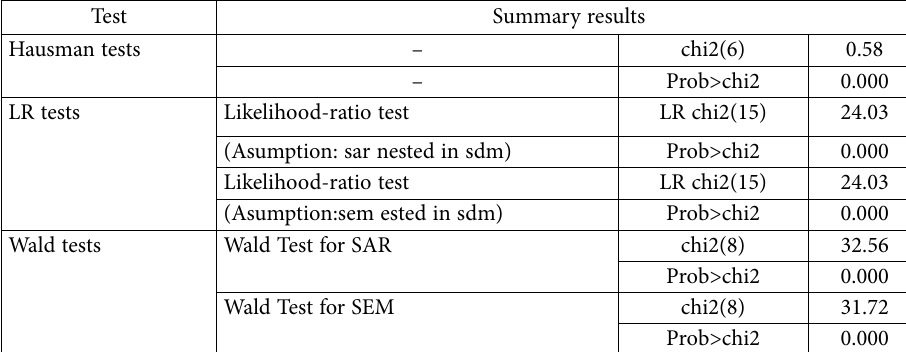
Table 8. Hausman, LR and Wald test